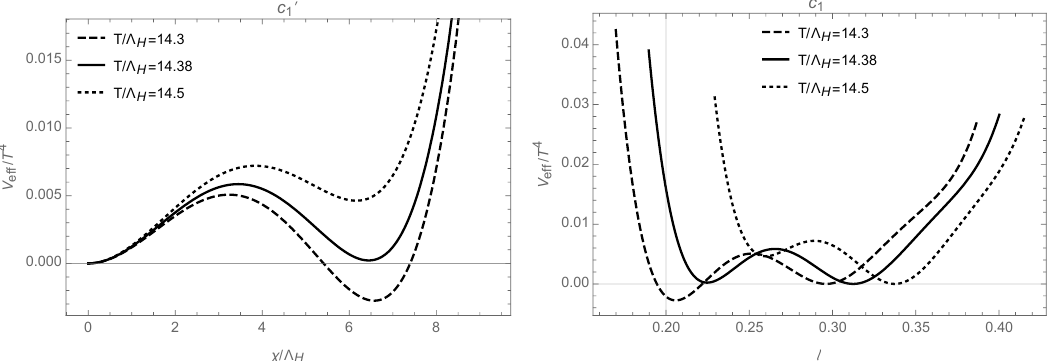
Figure 8 . The potential V e(cid:11) ( L; (cid:31); T ) =T 4 around T c; 3 = (cid:3) H = 14 : 38 as a function of (cid:31) (left) and ‘ (right) on the line c 0 linking the two minimum points given in (3.60) and (3.61). 1